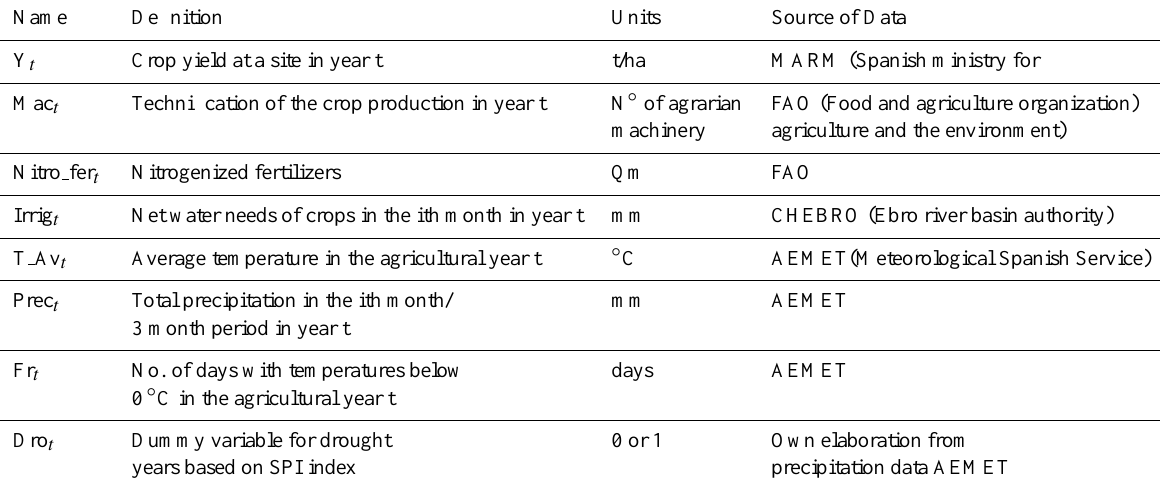
Table 4. Description of the variables in the crop production